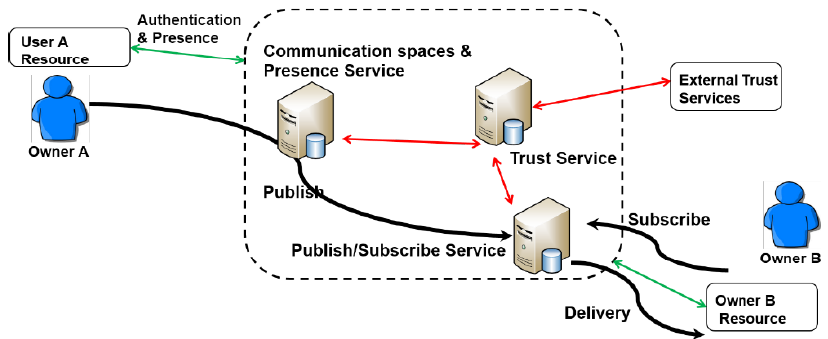
Figure 7. Information sharing of CPS communication hub.